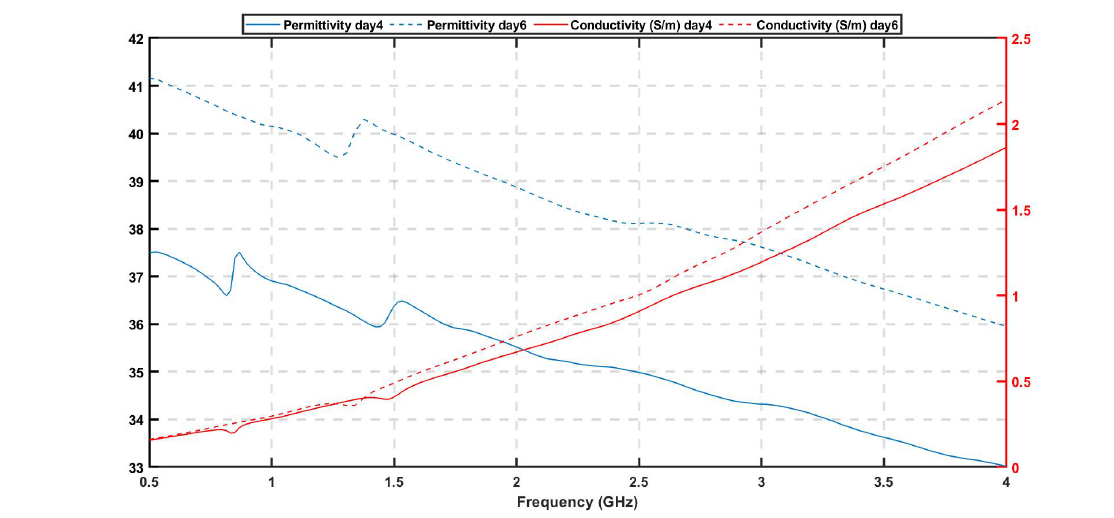
Figure 7. Dielectric properties of brain mimicking phantom at day 4 and day 6 after its